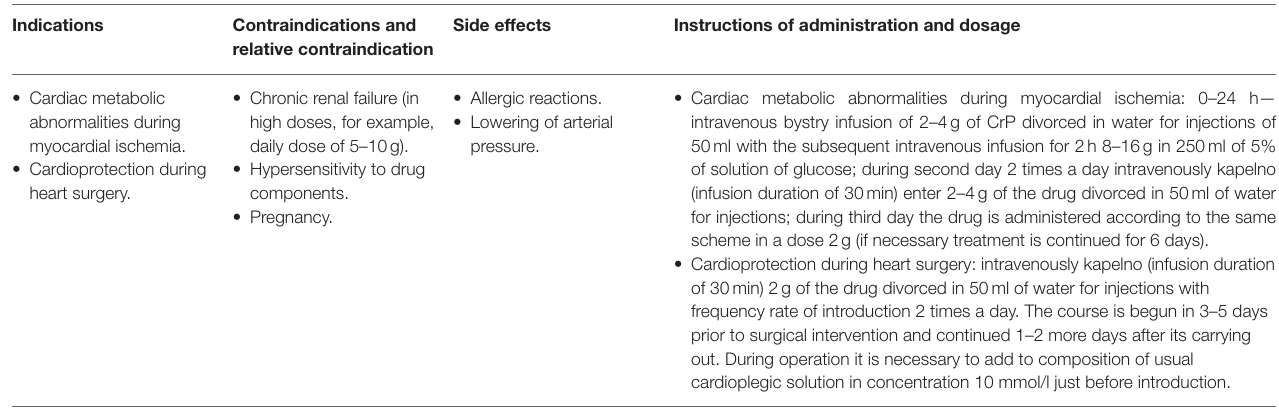
TABLE 2 | The indications, contraindications, side effects, and application instructions of CrP supplement for IHD.